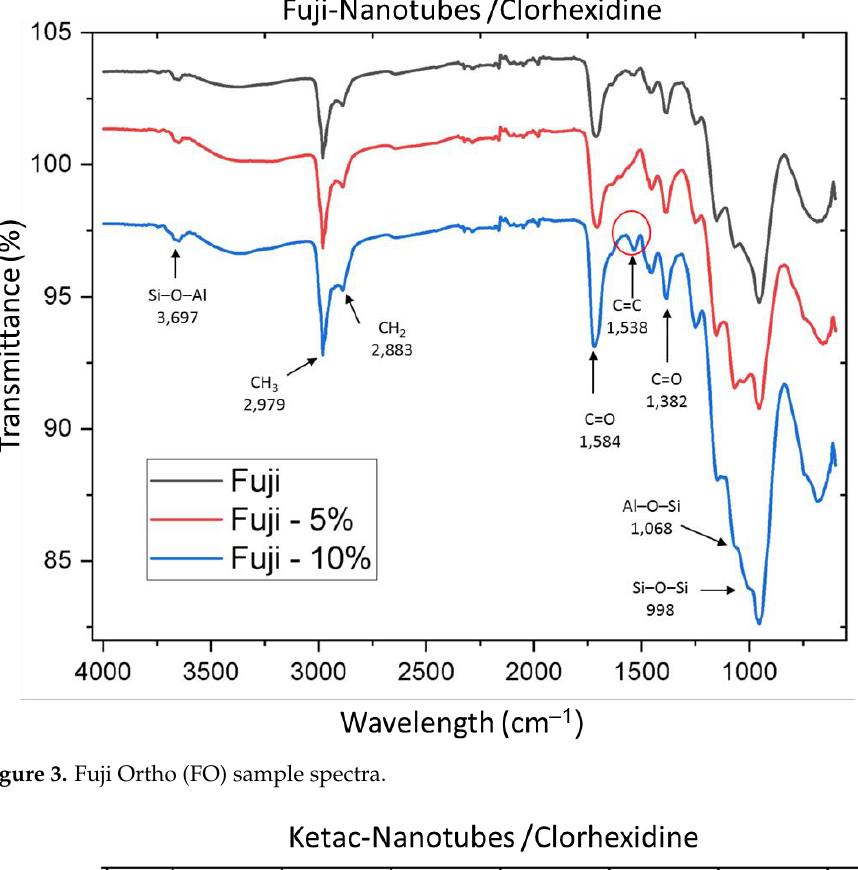
Figure 3. Fuji Ortho (FO) sample spectra.